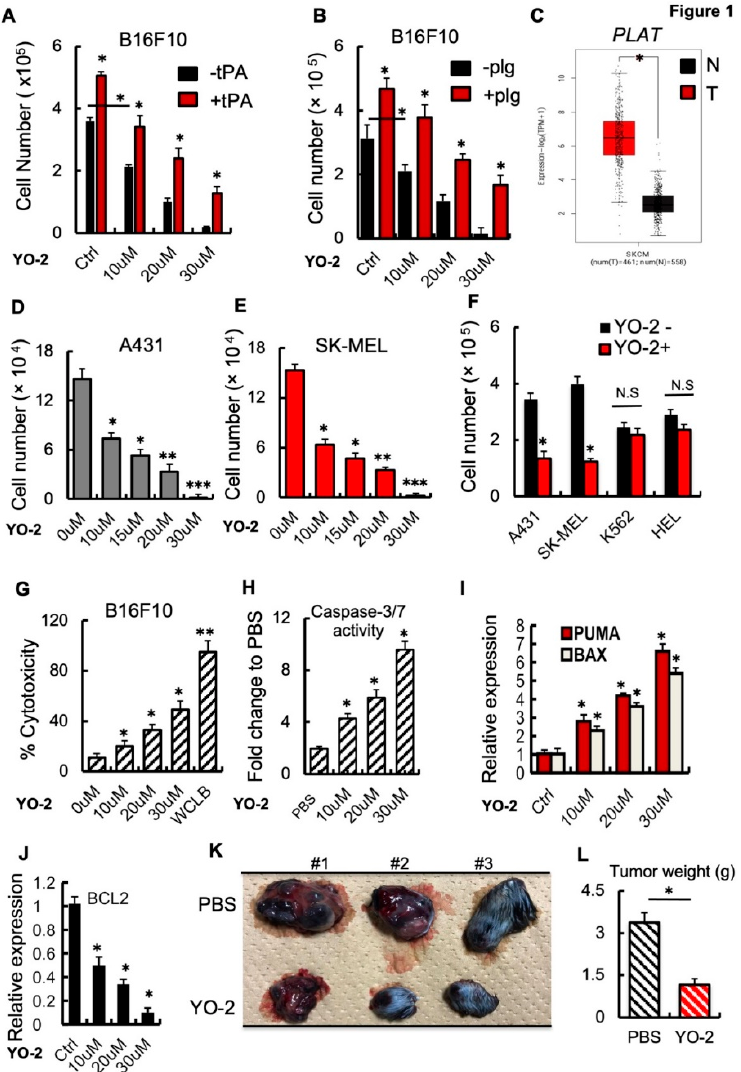
Figure 1. YO ‐ 2 induces apoptosis in melanoma. ( A , B ) Cultured B16F10 cells were treated with/with ‐ out rtPA ( A ) or plasminogen (plg) ( B ) and cotreated with the indicated concentration of the plasmin inhibitor YO ‐ 2. Cells were counted after 24 h ( n = 6). ( C ) Human tPA expression levels in tumor (T) and normal adjacent (N) tissues of human skin cutaneous melanoma (SKCM) patients were re ‐ trieved from the TCGA database and analyzed by Timer. ( D , E ) Human A431 ( D ) and SK ‐ MEL ‐ 28 ( E ) skin cancer cells were cultured with/without various concentrations of YO ‐ 2. Viable cells were enumerated after 24 h n = 6). ( F ) Indicated cell lines (human A431 and SK ‐ MEL ‐ 28 melanoma or myeloid K562 and HEL cells) were cultured in the presence or absence of YO ‐ 2 (10 uM/mL). Viable cells were counted after 24 h ( n = 6). ( G ) The LDH assay kit was used to determine cytotoxicity in B16F10 cells treated with/without YO ‐ 2 after 24 h ( n = 6). ( H ) Caspase 3/7 activity in supernatants of B16F10 cells treated with/without YO ‐ 2 ( n = 6). ( I , J ) Fold change in apoptosis ‐ linked PUMA and BAX ( I ) and the anti ‐ apoptosis ‐ linked BCL2 ( J ) gene expression in YO ‐ 2 ‐ treated and control B16F10 cells by qPCR ( n = 3). Expressions were compared to untreated/carrier cell controls. ( K , L ) B16F10 wild ‐ type tumor ‐ bearing mice were treated with/without the plasmin inhibitor YO ‐ 2 starting from day 5. On day 12, representative macroscopic tumor images were taken ( K ), and the tumor weight was determined ( L ; n = 6). Data are expressed as mean ± SEM (unpaired Student’s t ‐ test or one ‐ way ANOVA * p < 0.05, ** p < 0.01, *** p < 0.001). Next, we examined the effect of YO ‐ 2 on the expression of the pro ‐ apoptotic genes Puma and Bax in cultured B16F10 cells. The transcript expression levels of Puma and Bax increased with increasing concentrations of YO ‐ 2 (Figure 1I). In contrast, the apoptosis ‐